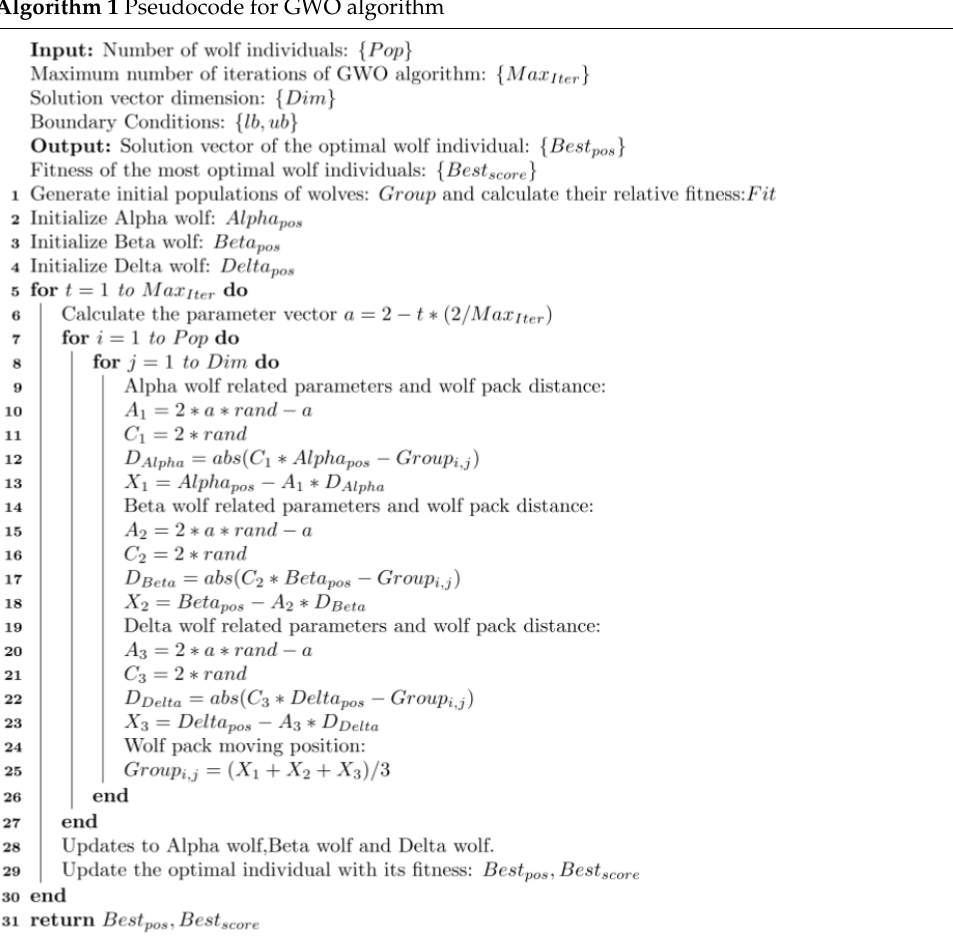
Figure 3. Position update of wolf groups in GWO algorithm. Algorithm 1 Pseudocode for GWO algorithm